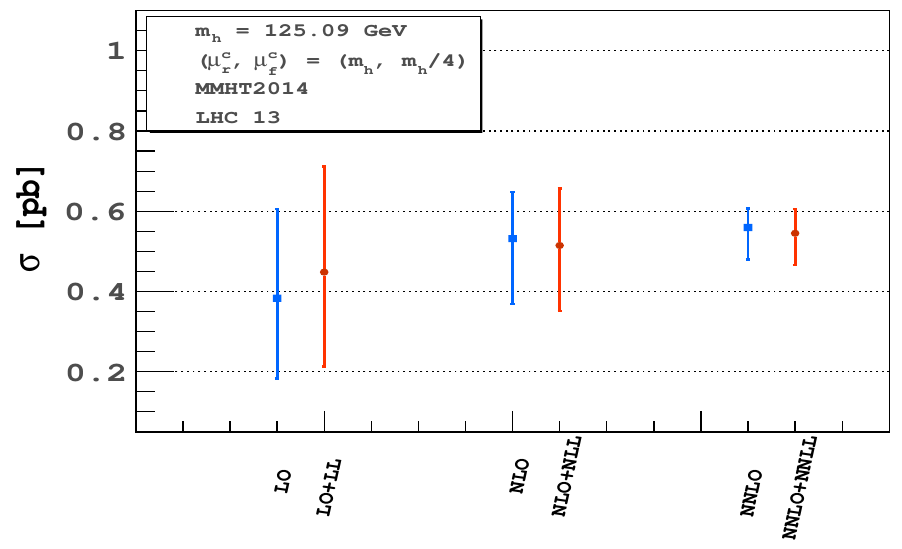
Figure 3 . The perturbative convergence is shown for (cid:12)xed order and resummed order for 13 TeV LHC. The central scale is (cid:12)xed at (1 ; 1 = 4) m h and the asymmetric error bars are obtained by varying the (cid:22) r ; (cid:22) f scales by (1 = 2 ; 2) around their central